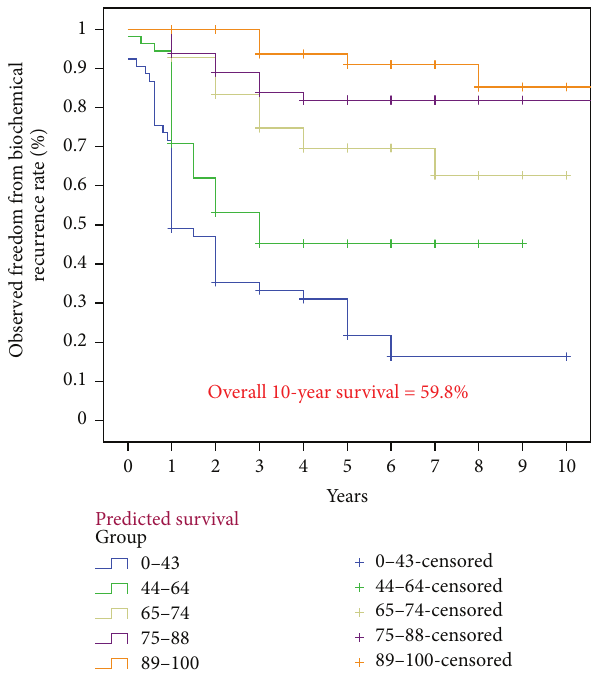
Figure 2: Observed freedom from biochemical recurrence rates according to the 2006 Stephenson nomogram.